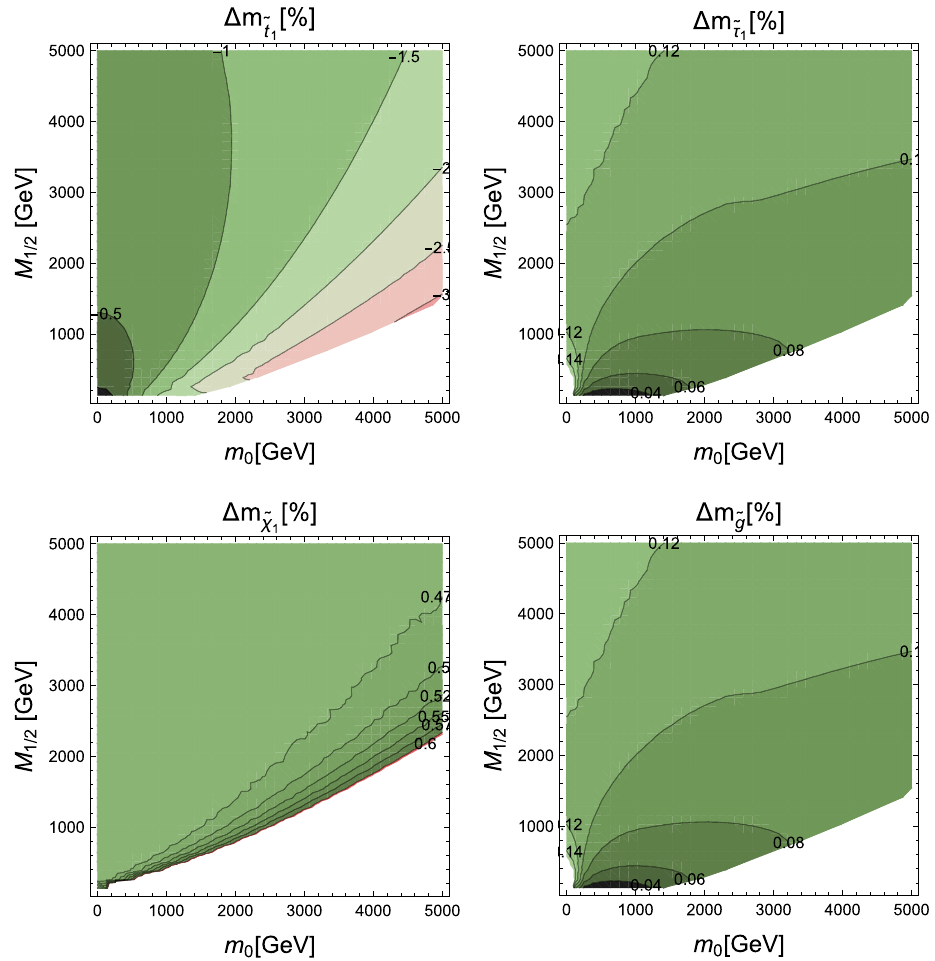
Fig. 5 The mass difference (cid:9) = m old − m new in percent between the old and new mass calculation using SARAH . The red boundary in the ˜ χ 0 m old shows the area with a higgsino LSP which is discussed in the text in more